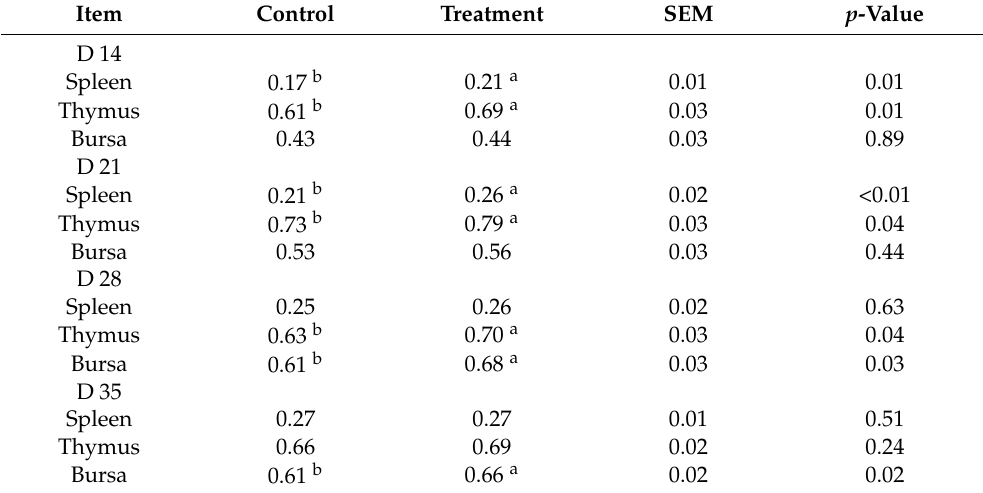
Table 6. Effects of two supplementary doses of vitamin A on relative organ weight (%) of immune organs in young laying pullets 1